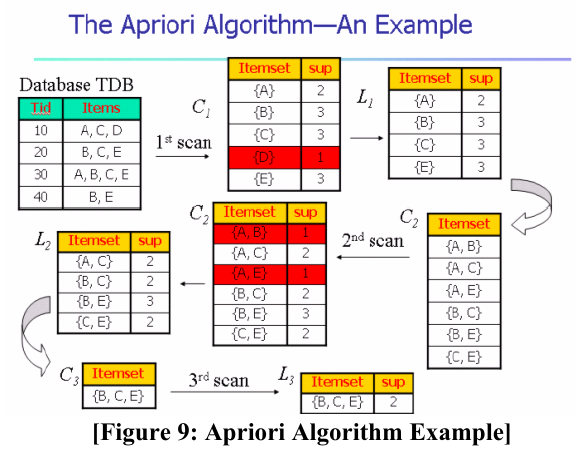
[Figure 9: Apriori Algorithm Example]